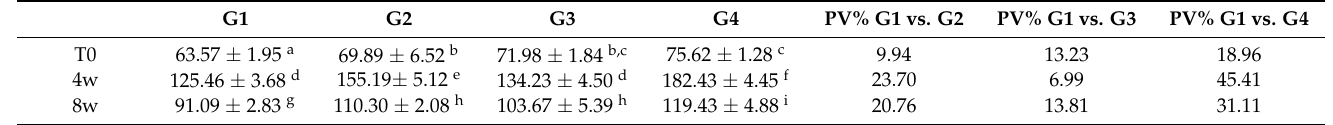
Table 4. Radical scavenging activity evaluated by ABTS method in egg yolk compared to the control.